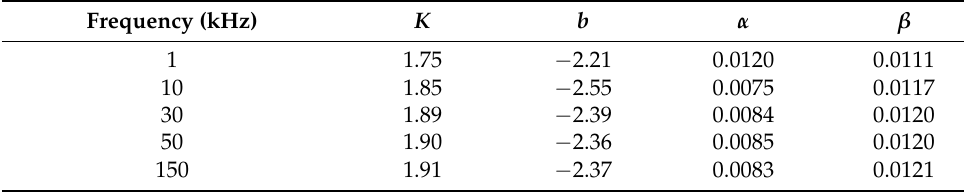
Table 4. Fitting parameters of AE signal energy attenuation of T3 specimen.